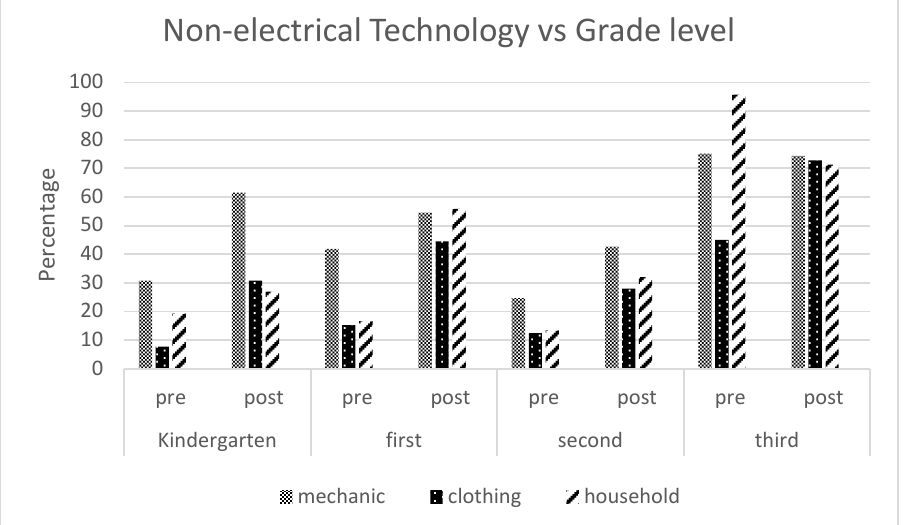
Figure 5. Non-electrical Technology by grade